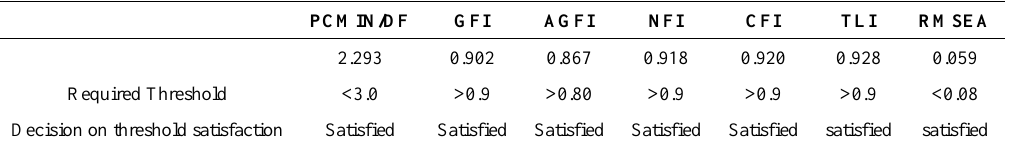
Table 4. Confirmatory factor analysis